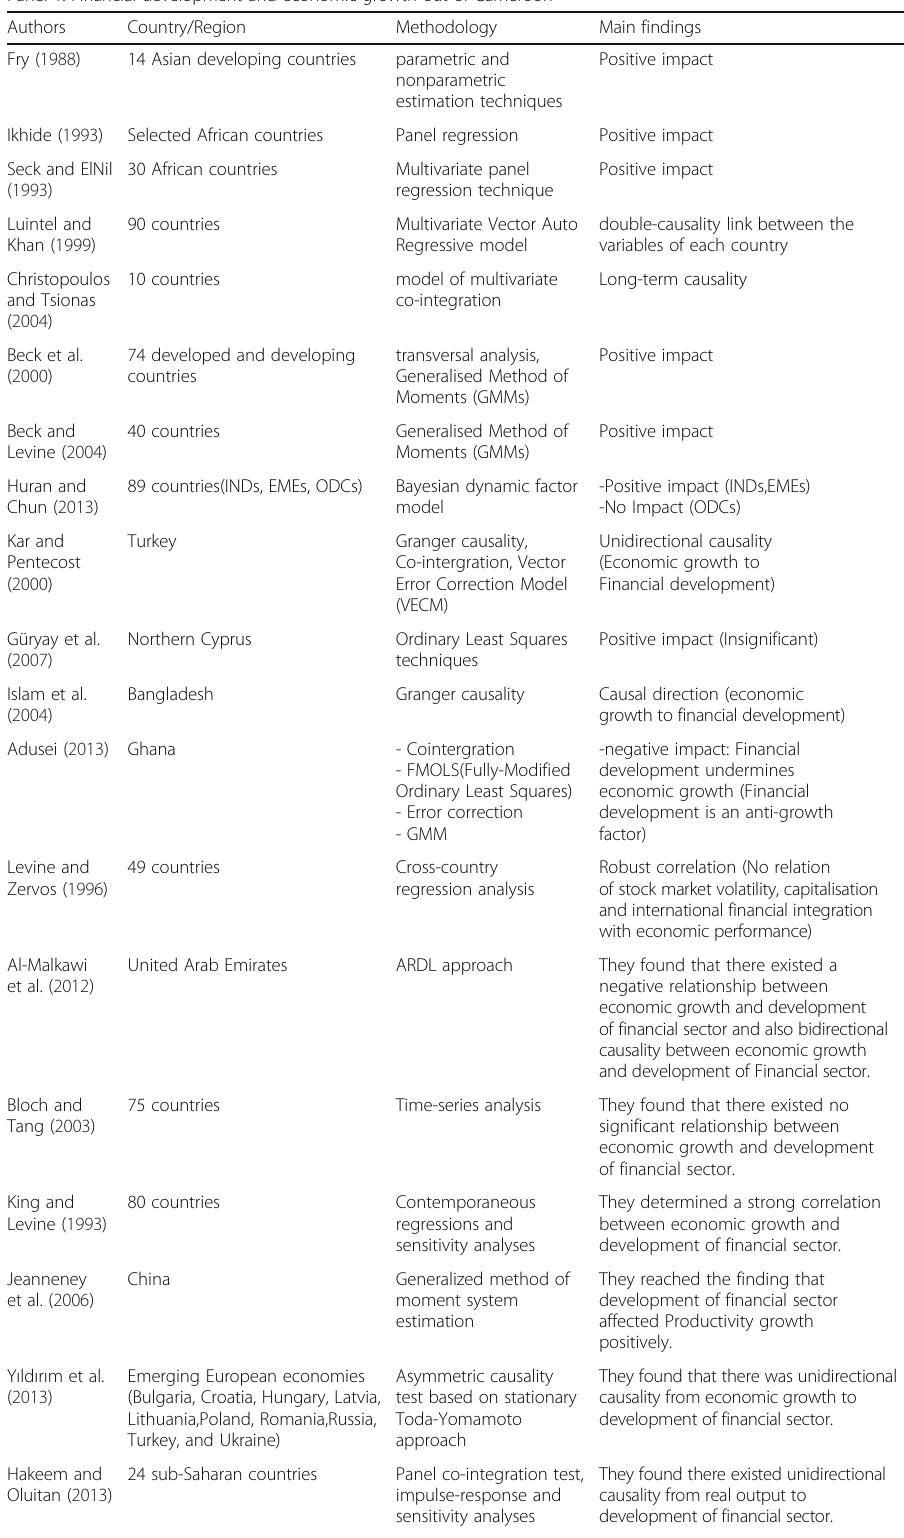
Table 1 Literature review excluding Cameroon Panel 1: Financial development and economic growth out of